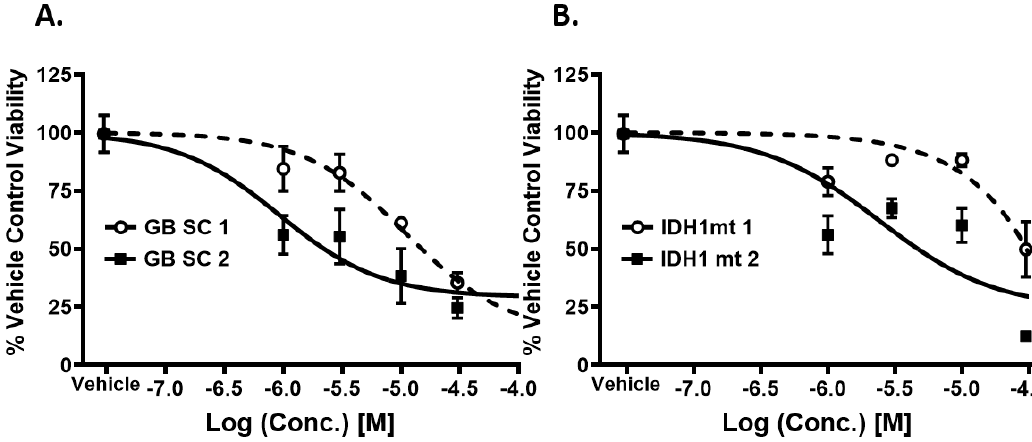
Figure A2. The mTORC1 inhibitor rapamycin is dose-dependently toxic to GBMSCs. ( A ) Rapamycin, also known mTORC1-specific inhibitor, dosed at increasing dosages in 2 patient-derived IDH1 wildtype GBMsc and in ( B ) 2 IDH1 mutant cell lines, with IDH1 mt 1 being a patient-derived GBMsc and IDH1 mt 2 a patient-derived WHO-grade III astrocytoma, which is known to develop into glioblastoma (WHO grade IV astrocytoma). Experiments were conducted using Trypan Blue Exclusion in patient-derived GBMsc. Experimental points are an average of 3 experiments. Error bars are the standard error of the mean. The curve is a 4-parameter-model sigmoidal dose–response curve. The X-axis is drug concentration, while the Y-axis is % viability of GBMsc normalized to vehicle control.